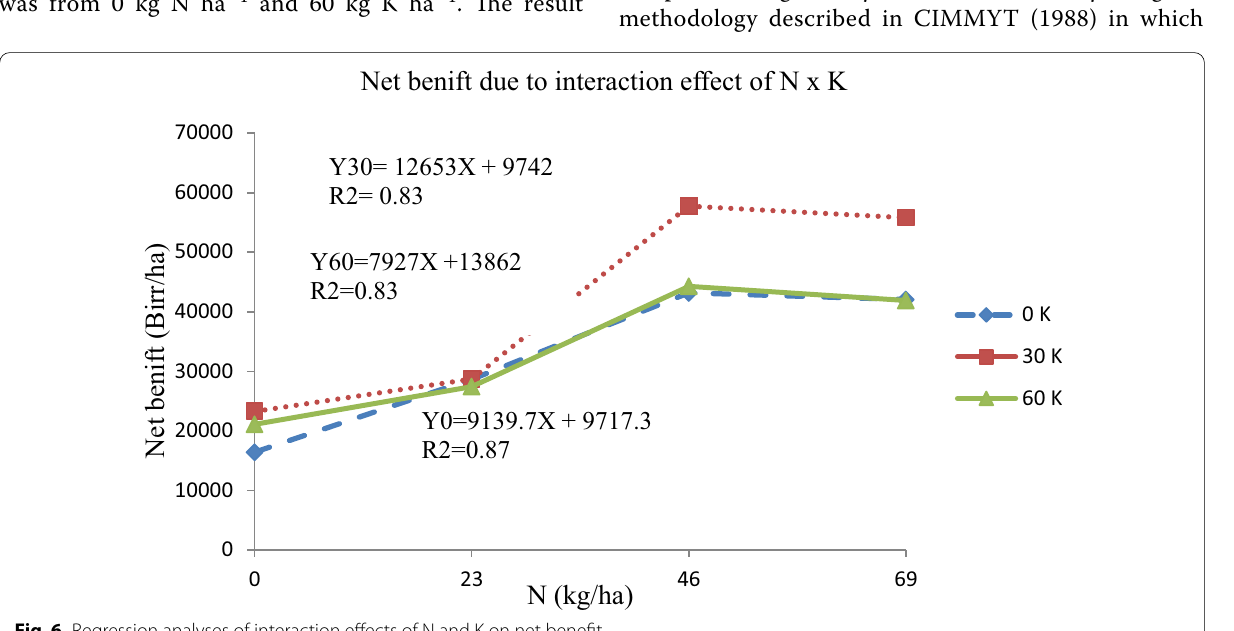
Means followed by the same letters within a column are not significantly different at 5% probability level S standard deviation